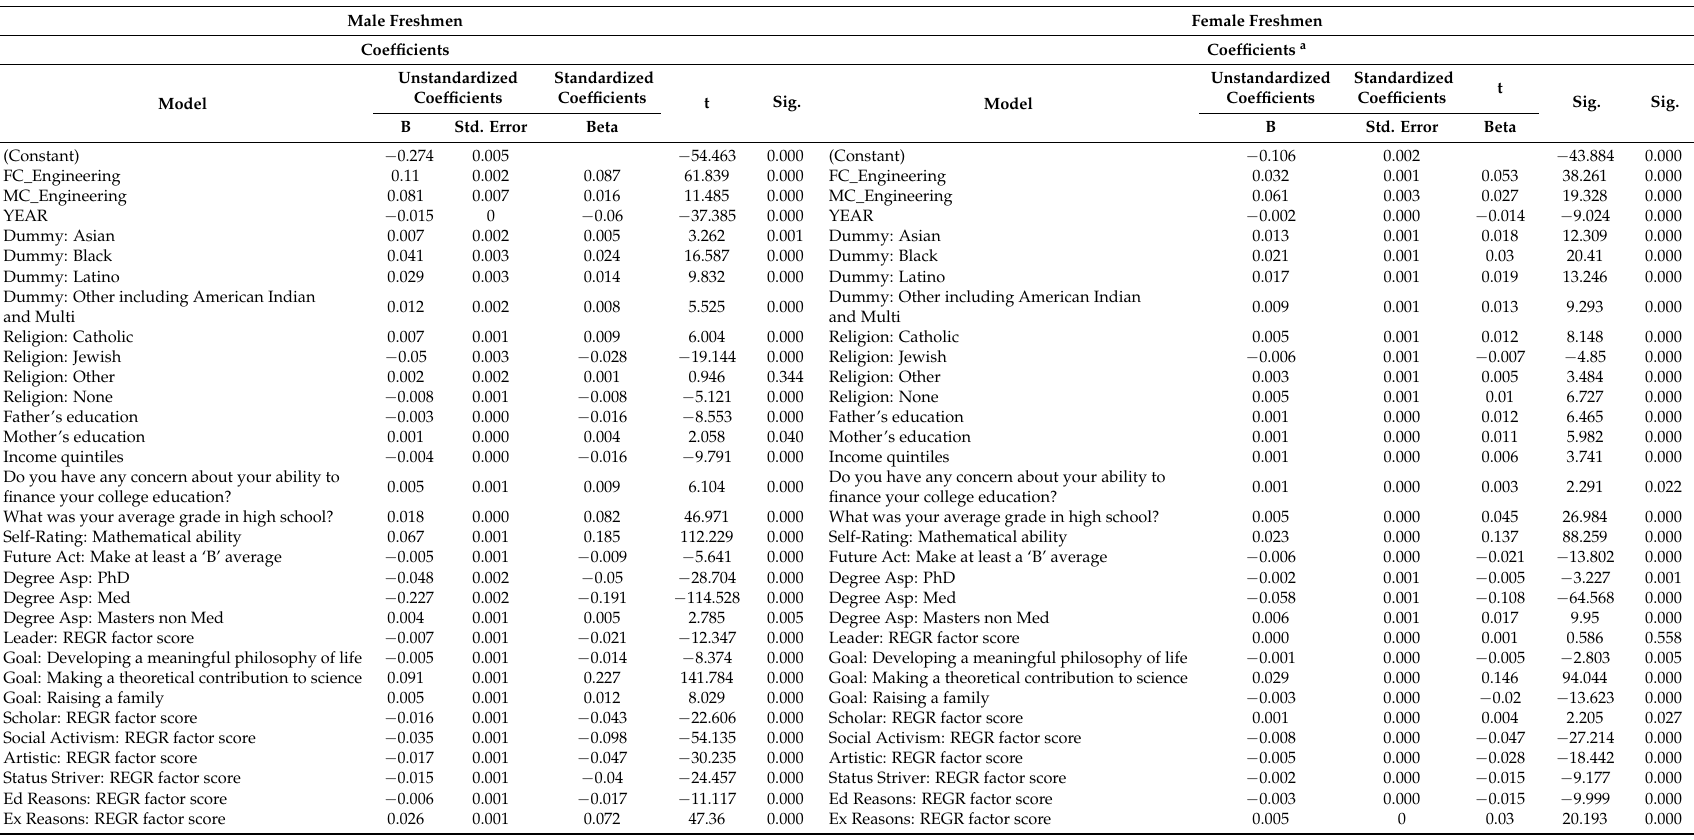
Table A4. OLS Regression Results, Final